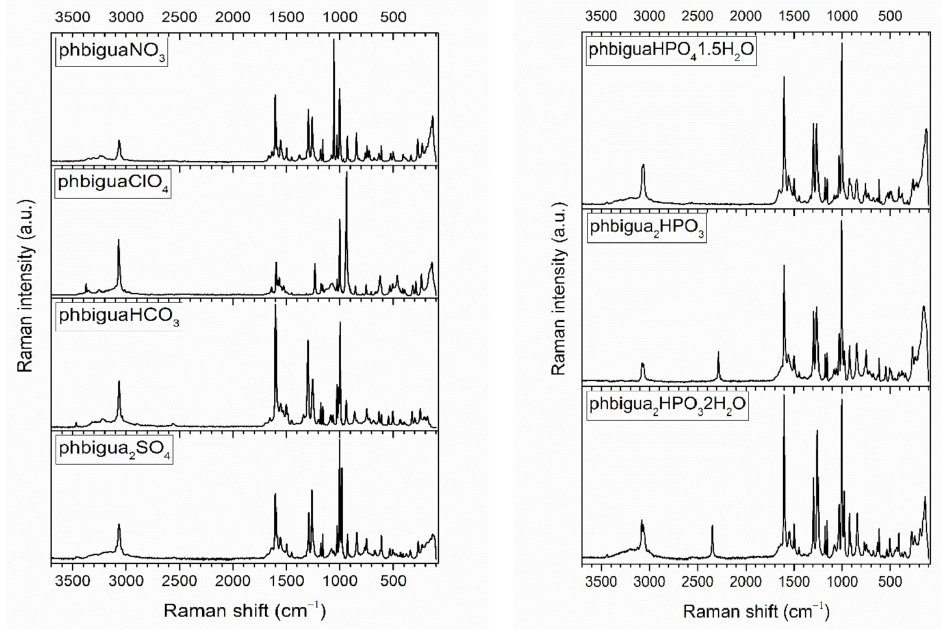
Figure 8. FT Raman spectra of N -phenylbiguanidium(1+)